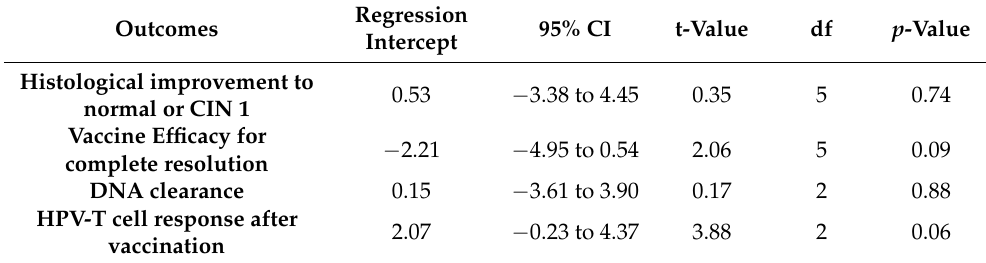
Table 3. Assessment of publication bias by the Egger’s regression